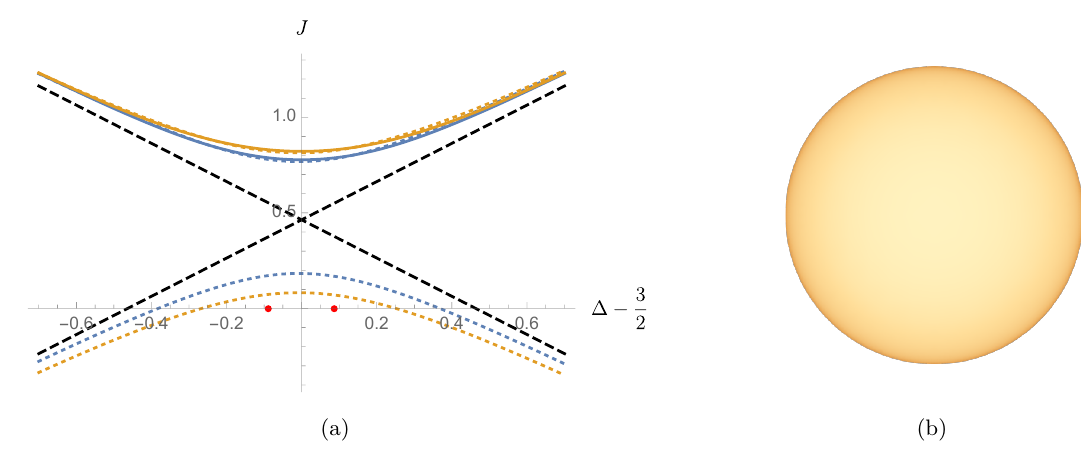
Figure 13 : The interpolation of data points and their fit for two sets of points considered in fig. 12 is given. The analytic continuation is obtained once the fit is found. The ✏ and its Figure 8 . (a) Estimate of the leading Regge trajectory in the critical 3D Ising Model (from [54]), shadow are represented by the two red dots. We see the prediction for  ✏ by looking at the showing its two branches, the orange (outermost) curve being the preferred one. (b) Angular intersection of the curves and the  axis. dependence of the camera signal, similar to figure 6. The optical parameter ( | p | L = 8 was used) has little influence on the